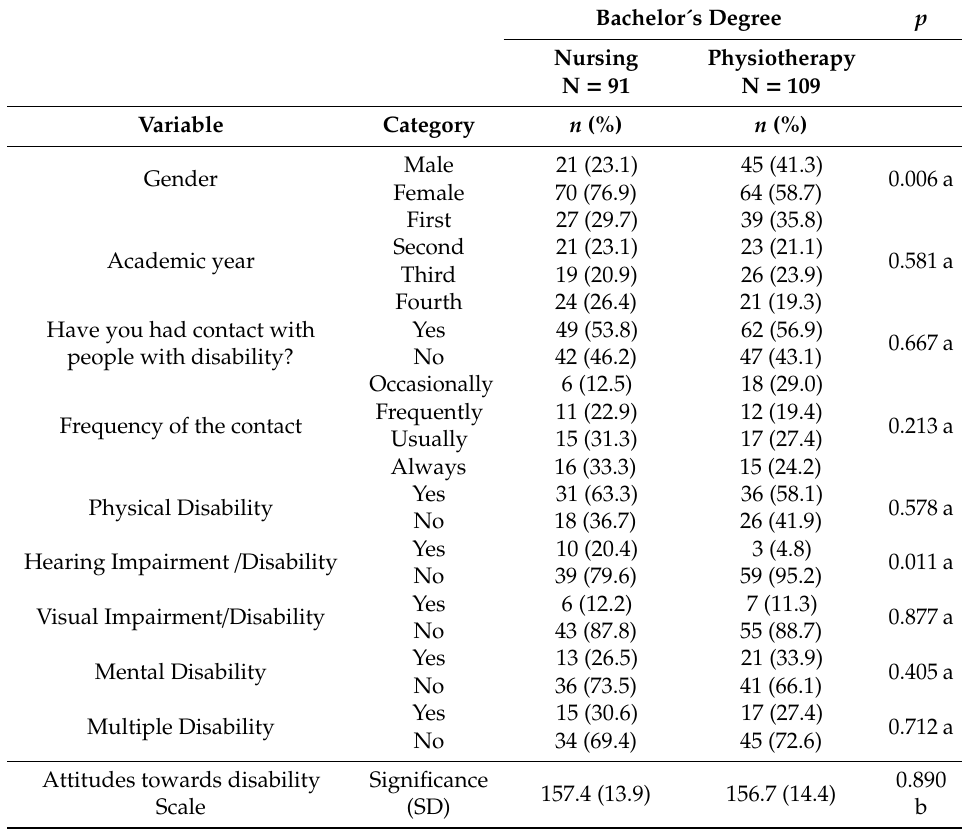
Table 2. Comparison between